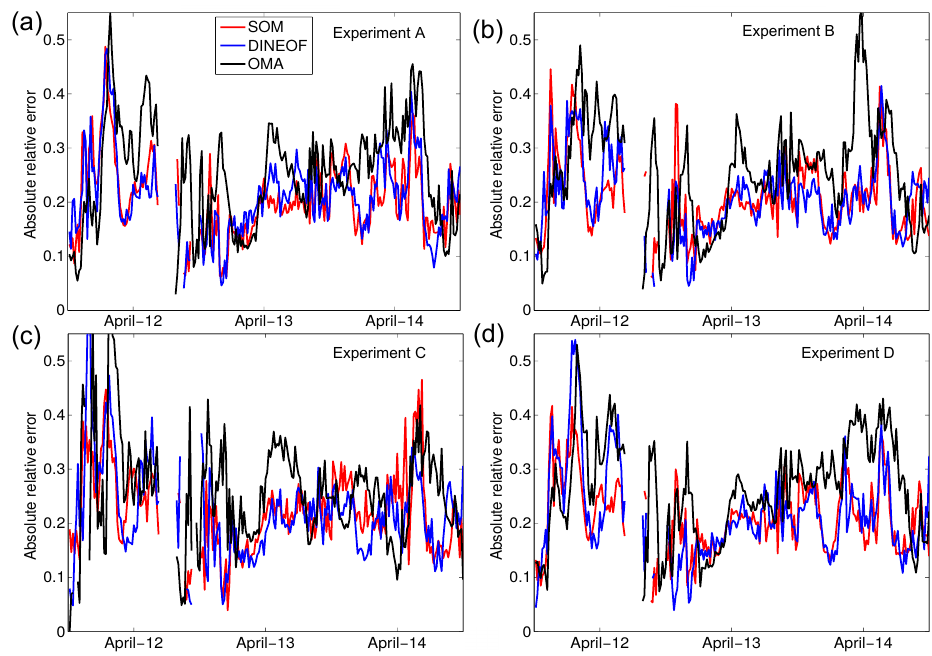
Figure 11. Time series of the spatial average of the pixel-by-pixel absolute relative error of the LCS computed from the three filled HFR velocities with respect to LCS obtained from the reference velocity field.